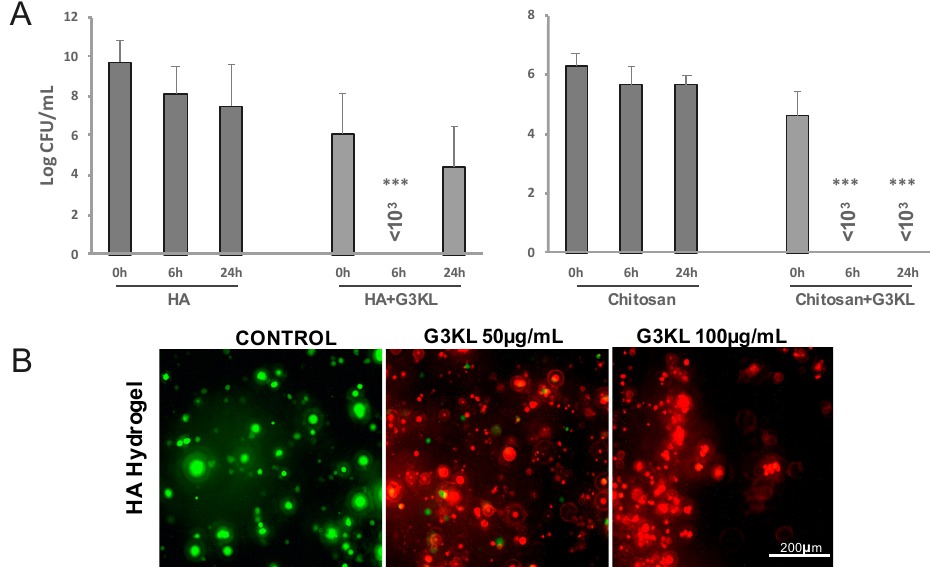
Figure 6. Assessment of the antibacterial effect and cytocompatibility of G3KL incorporated into HA and chitosan-based hydrogel matrices. ( A ) CFU count at different time points after incubation with hydrogels incorporating G3KL (100 µg/mL). ( B ) Live/Dead cell viability assay for progenitor cells seeded onto HA hydrogel incorporating G3KL (50 and 100 µg/mL). Live cells are stained green and dead cells are stained red. Data are presented as the means ± SD ( n = 3). p values were determined by unpaired Student’s test. *** p ≤ 0.001.